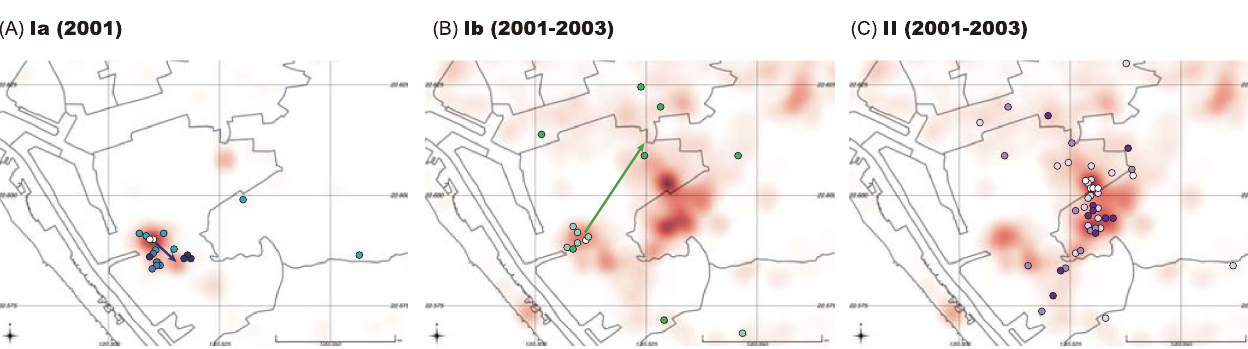
Fig 4. Differences in the pattern of geographical distribution of group Ia, Ib and II variants. Dots on the map indicate locations of patients’ residential areas. The intensity of color for each dot represents the chronology for the three groups of viral variants during their circulating period (A-C). The arrow on the map indicates the direction of virus spread based on the locations of MRCAs inferred in the MCC trees (A and B). Compared with groups Ia and Ib, the group II viral variants do not show a simple linear spreading route but did spread from the center of the clusters. Total isolates were plotted as dots in the indicated period, in colors blue, green and purple representing the groups Ia, Ib and II, respectively. The red shaded area illustrates all laboratory-confirmed dengue cases in the respective periods; the darker shading reflects higher case numbers.